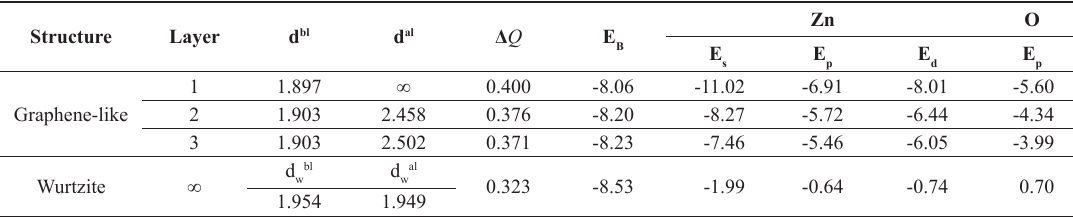
), net charge transfer (ΔQ), average energy and their contributions at each sub-level (E B